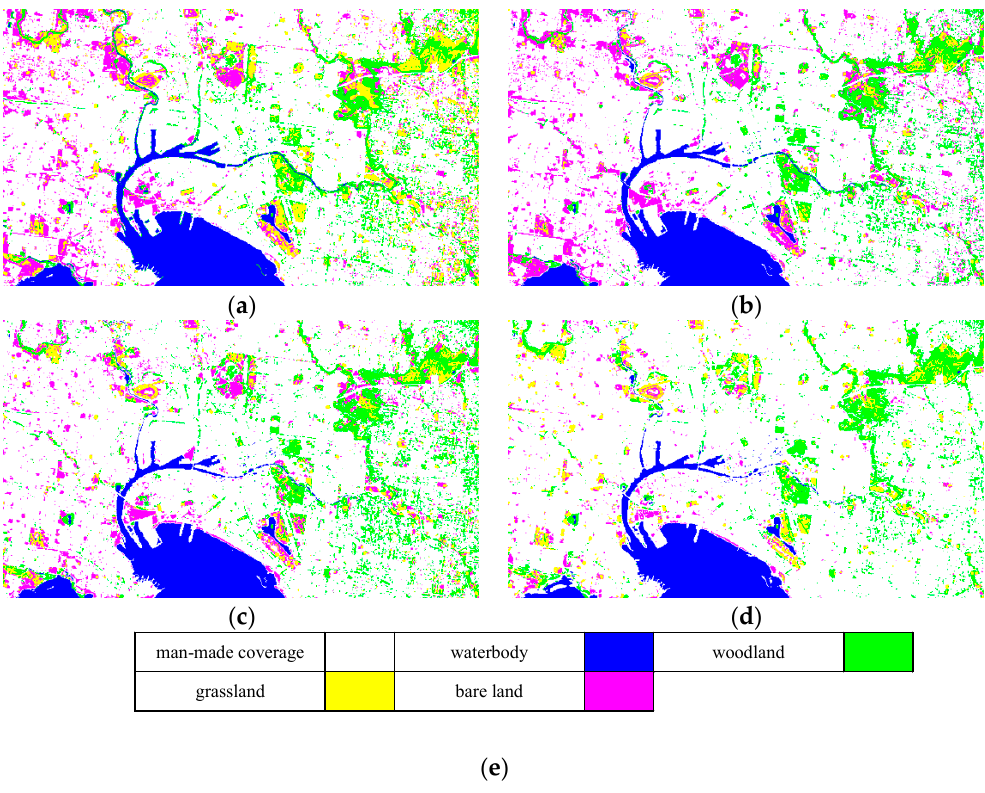
Figure 5. Classification maps of Melbourne from 2000–2012: ( a ) 2000; ( b ) 2004; ( c ) 2008; ( d ) 2012; ( e ) Legend of classification results. Table 3. Transfer matrix of land use types from 2000 to 2012 (km 2 ).